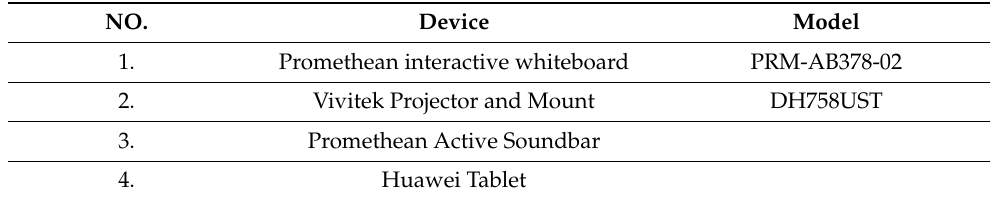
Table 8. Devices Used in the